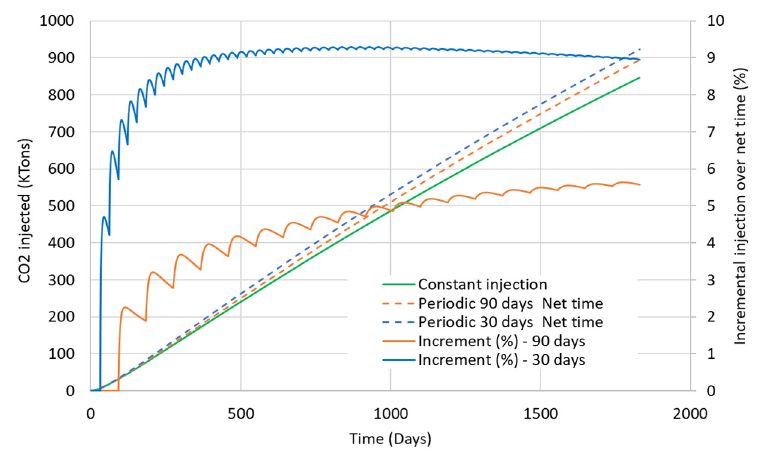
Figure 16. Up-flank injection, comparing one-month vs. three-month half-cycles. Longer cycles appear to reduce the benefit of periodic injection.